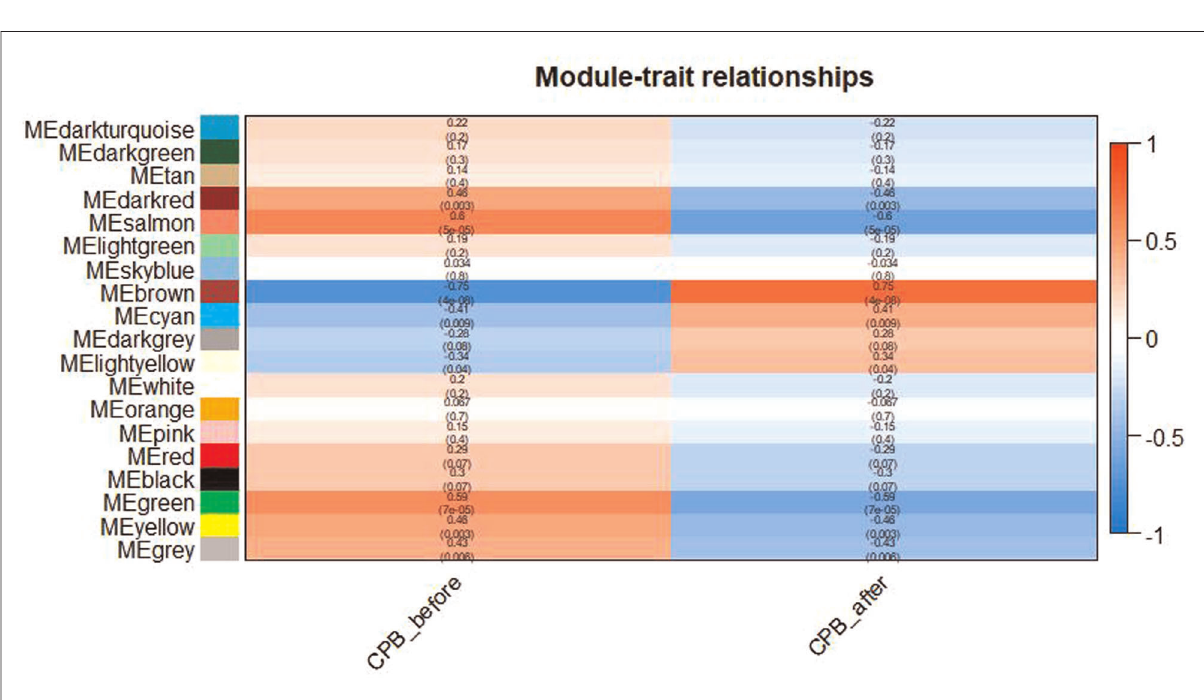
FIGURE 4 Diagram of Module-trait relationships. As shown in the fi gure, the brown module has the highest correlation with CPB_after( P =0.75×10 4e − 8